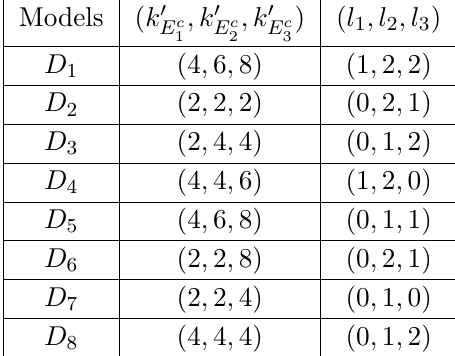
+ k is the weight ≡ k E c L E c i i transform as 1 l i under A . 4 i